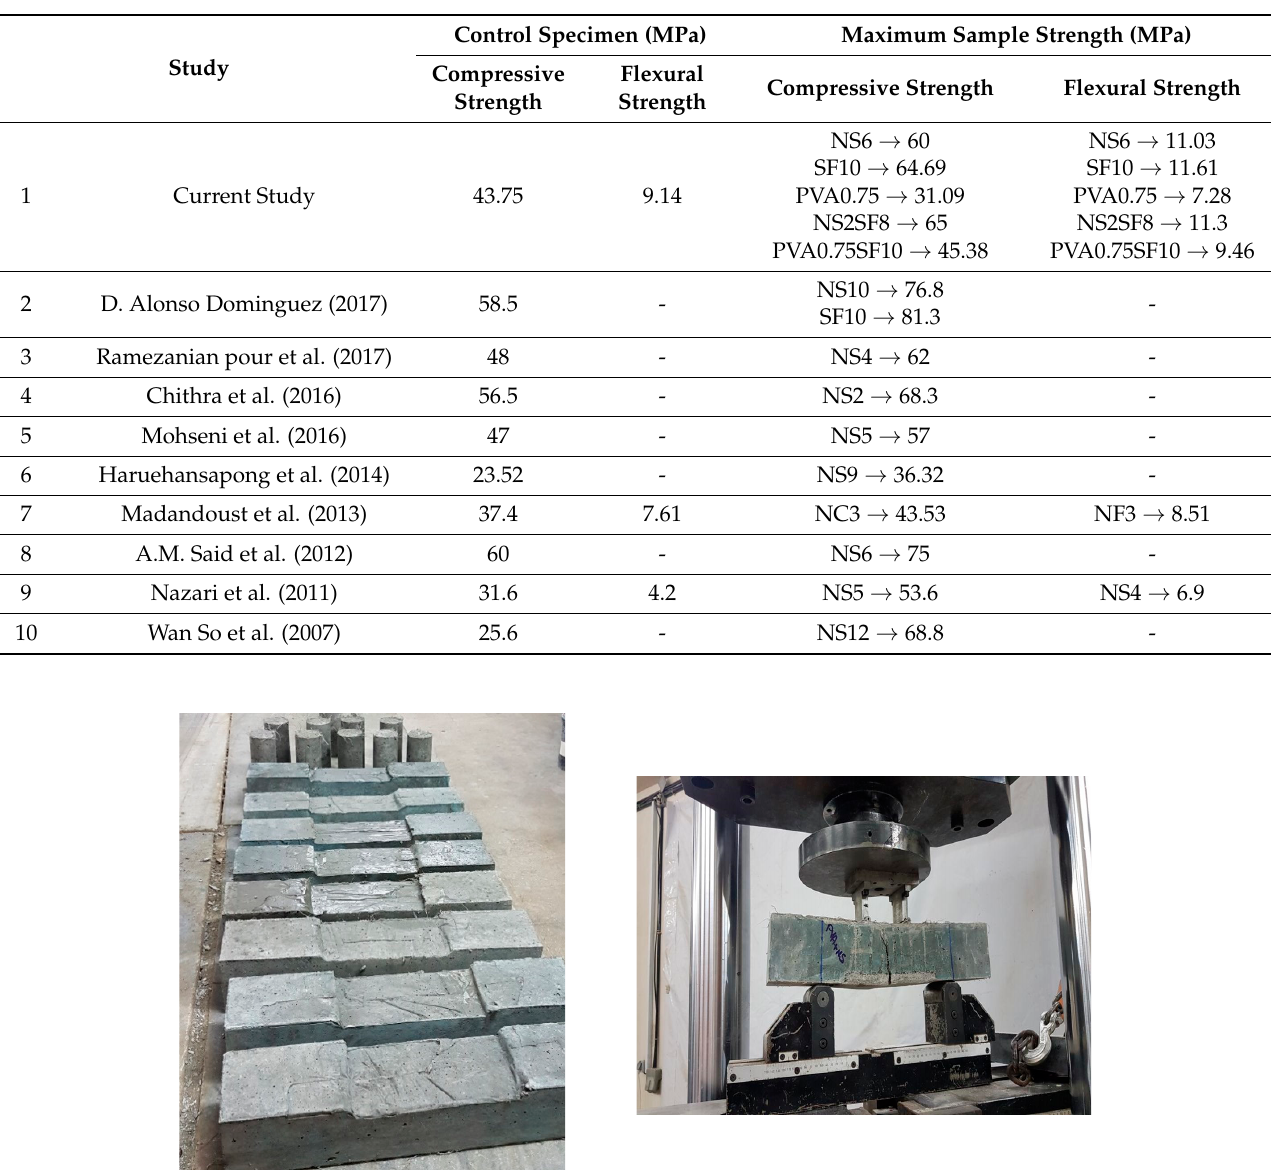
Table 13. Comparison of the compressive and flexural strength results of the current study with the previous research.